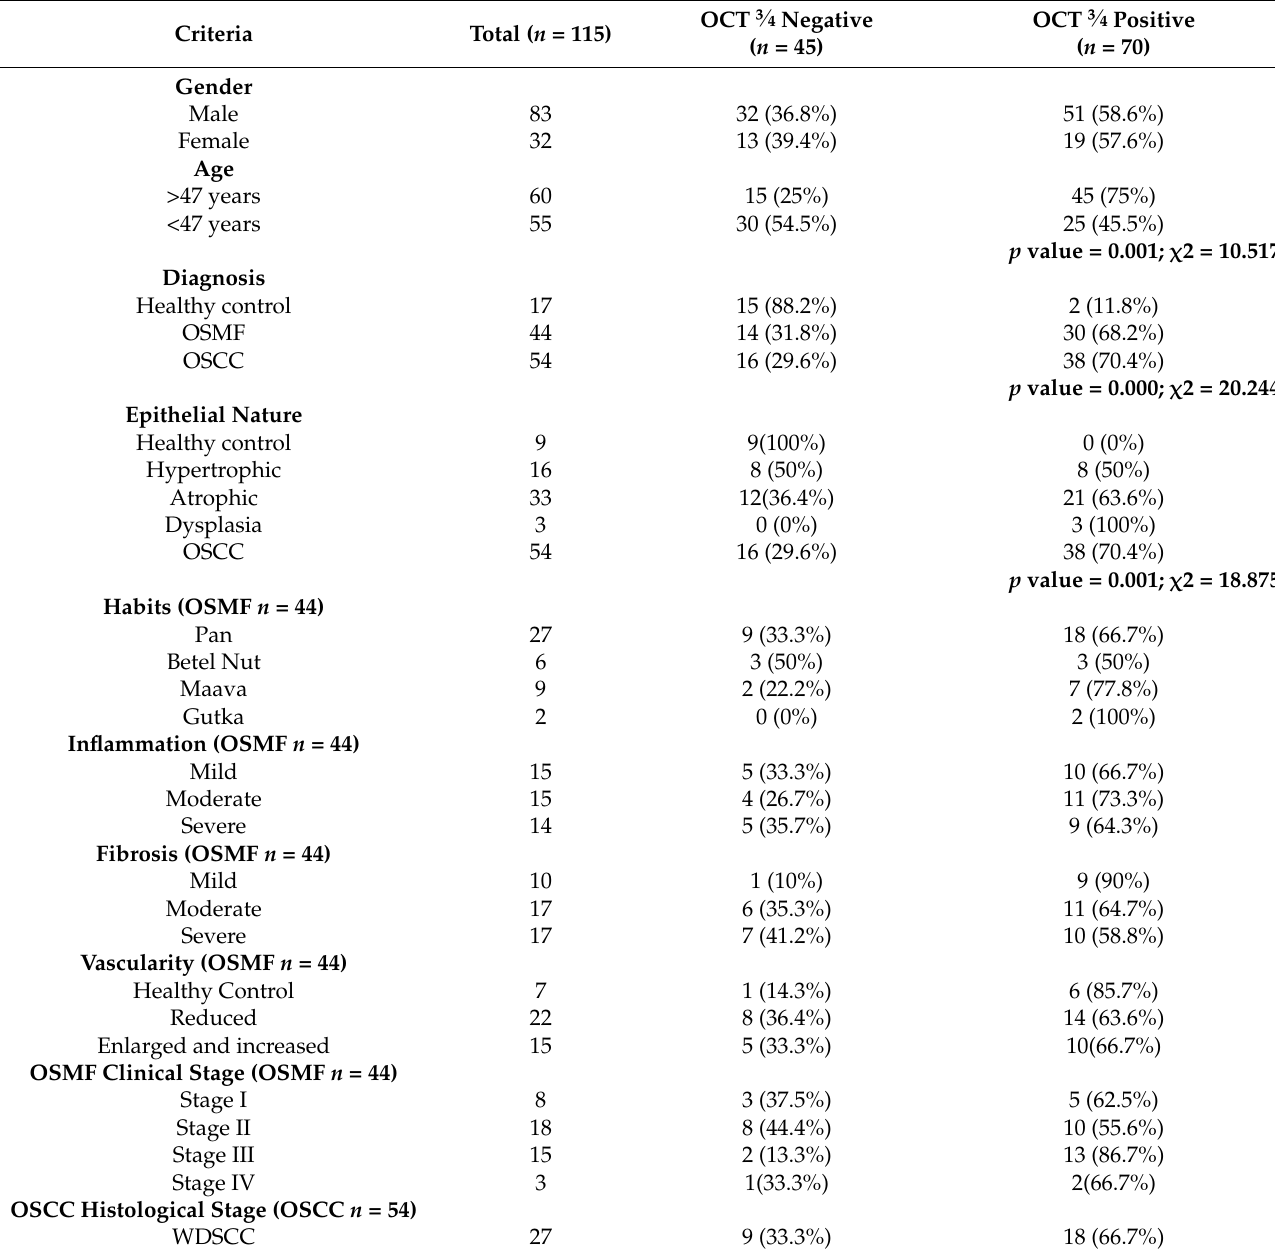
Table 2. Clinicopathological features of OCT 3/4 expression in OSMF, OSCC and healthy controls.